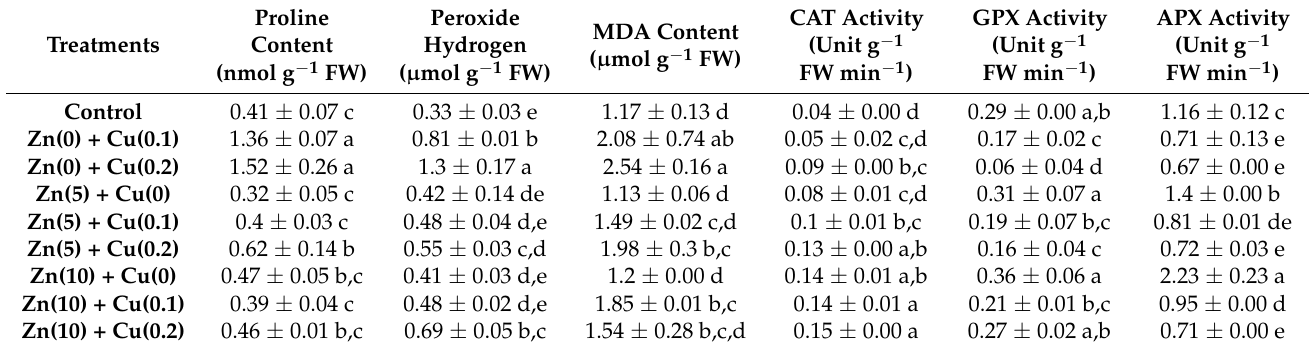
Table 2. Means related to the interaction effects of added Cu and Zn to a basal nutritional solution on biochemical properties of C. pepo